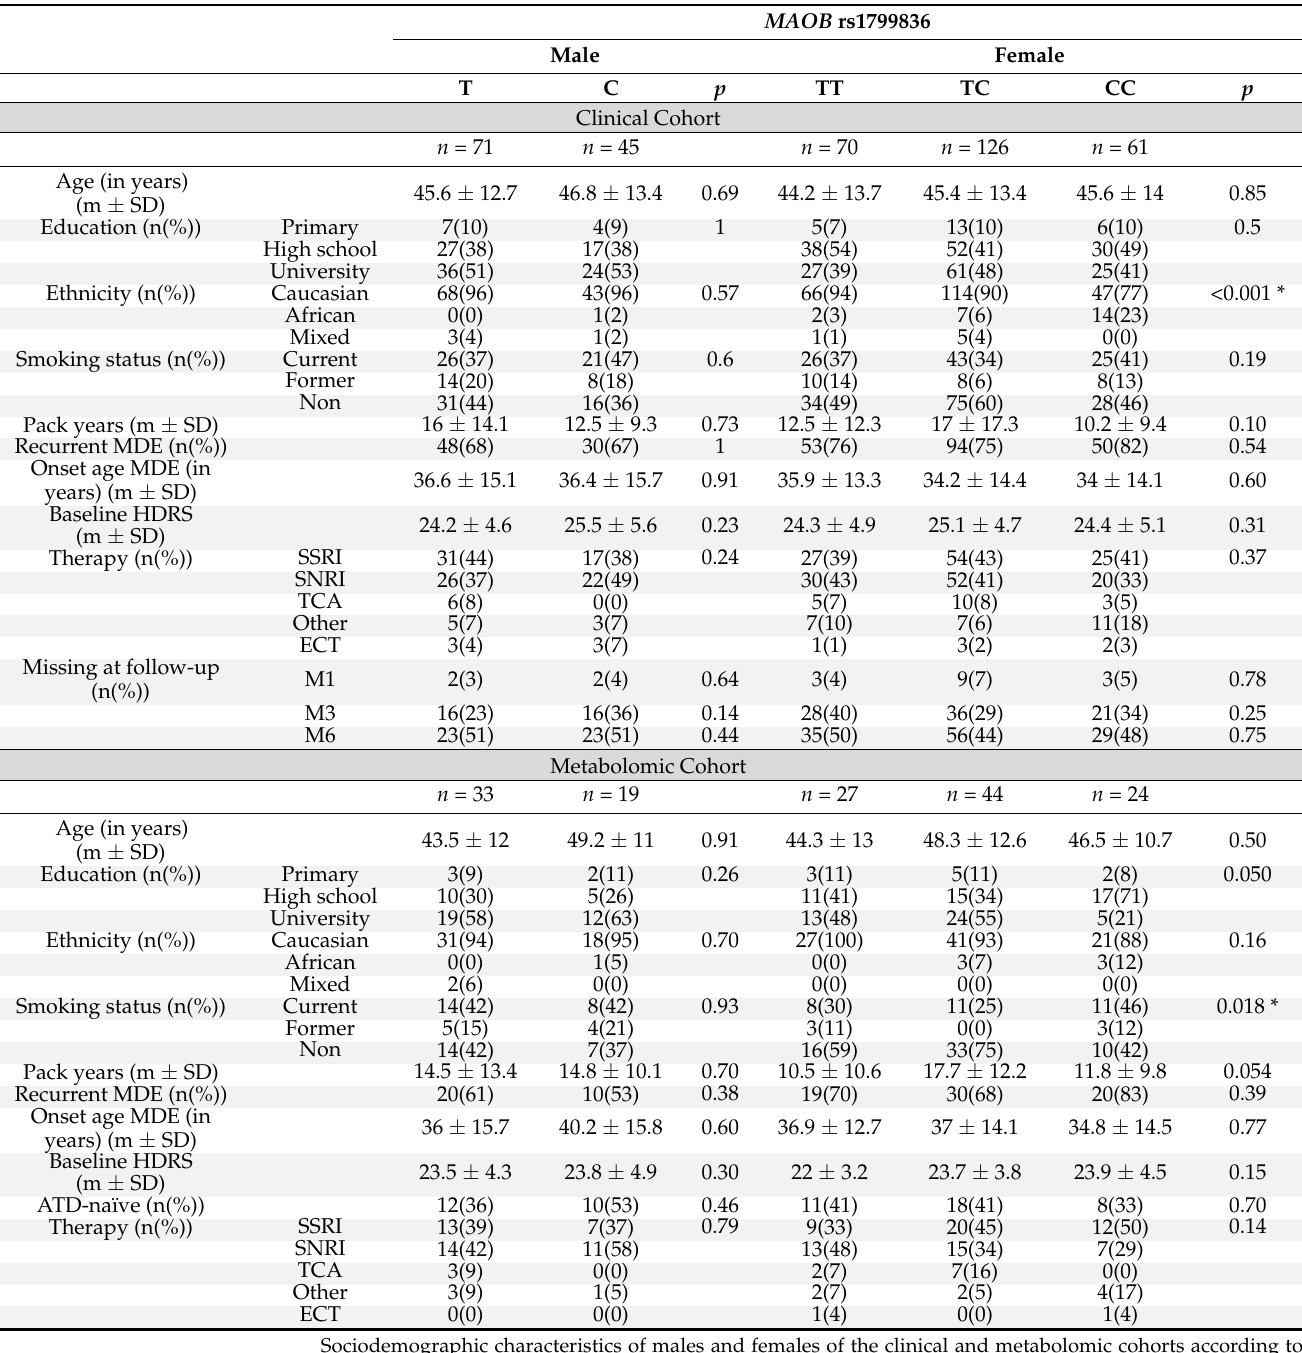
Table 4. Sociodemographic characteristics according to MAOB rs1799836 genotypes in males and females. MAOB